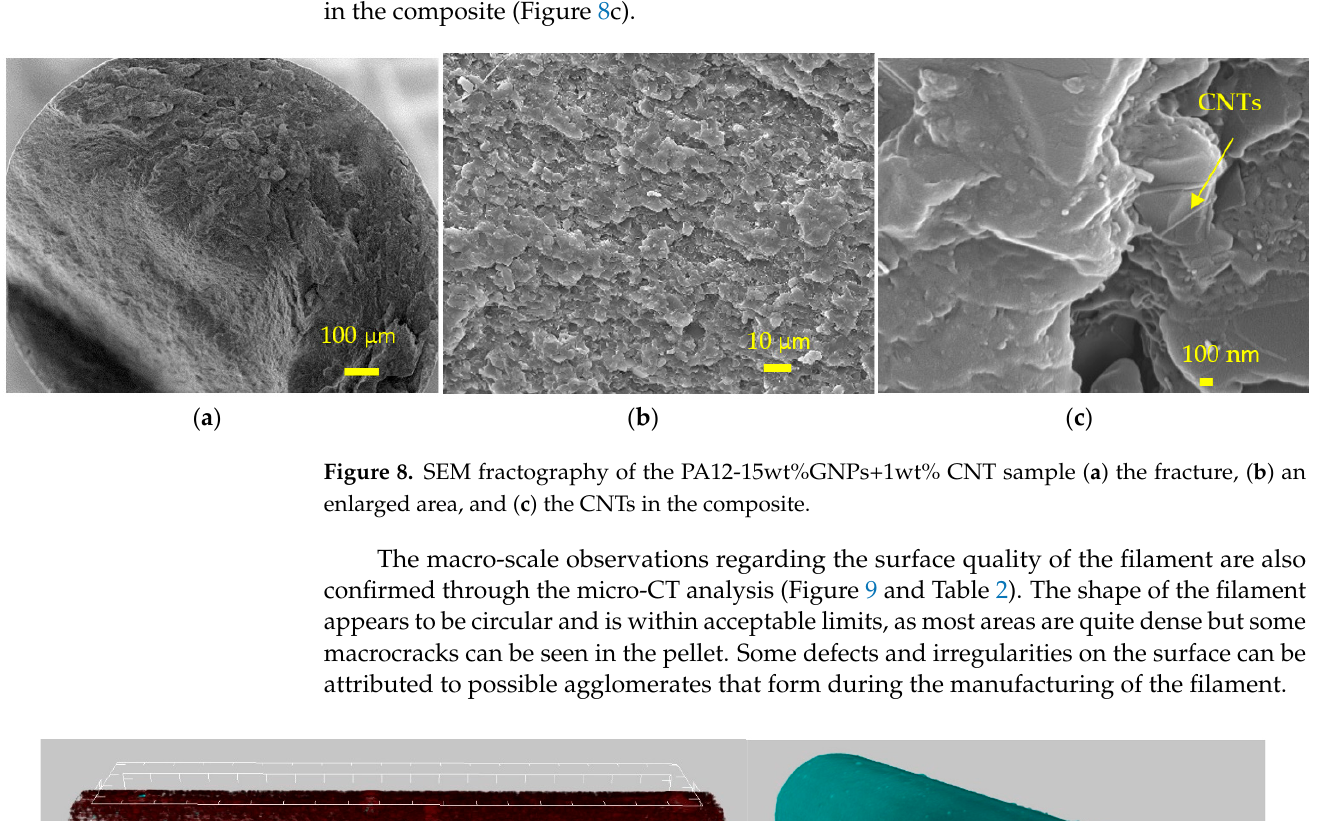
Figure 7. SEM fractography of ( a ) the neat PA12, ( b , c ) PA12 with 7 wt% CNTs, and ( d – f ) the PA12 with 20 wt% CNTs@CFs. PA12_15%GNPs+1wt%CNT sample (Figure 8). The composite has a dense structure, and